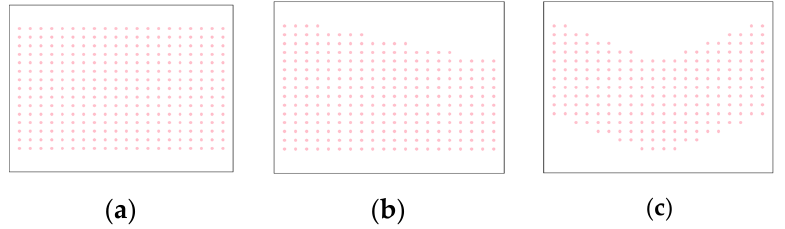
Figure 5. Schematic diagram of the distribution of peach trees ( a ) Rectangular distribution; ( b ) Trapezoidal distribution; ( c ) Irregular distribution.